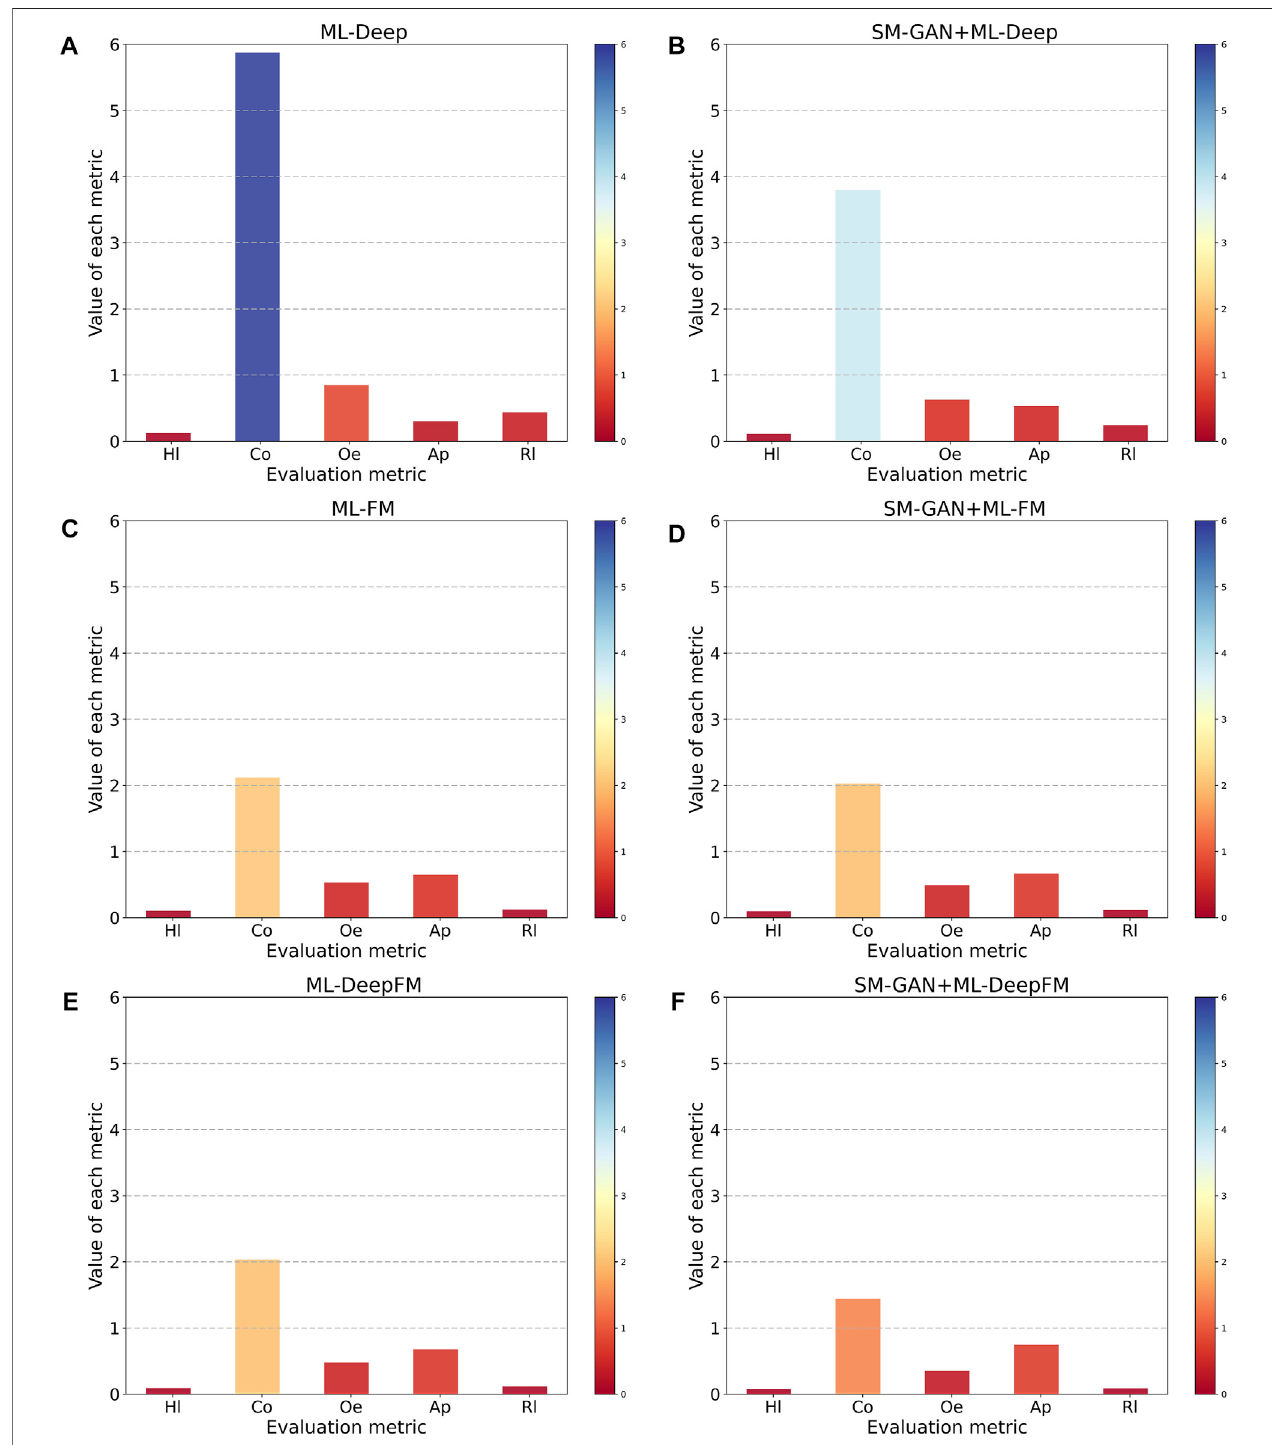
FIGURE 5 | The relationship between SM-GAN with ML-DeepFM.